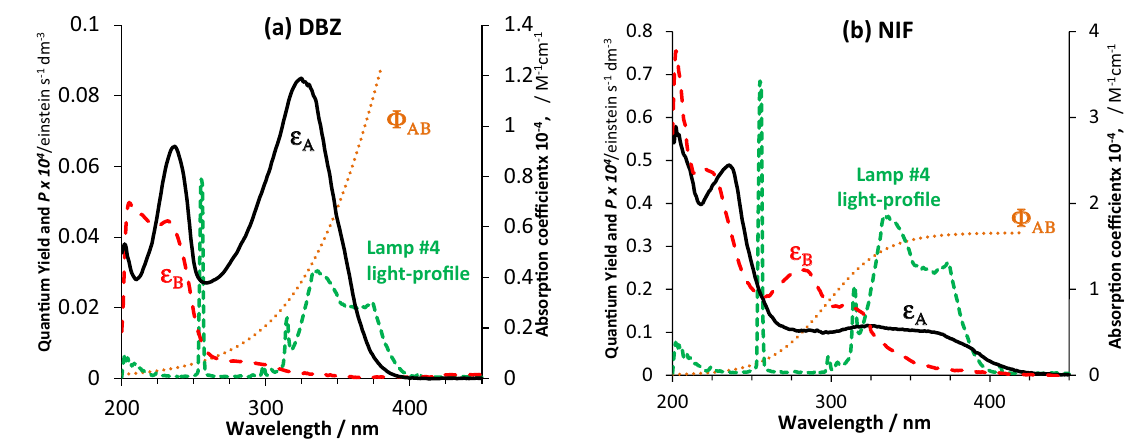
Figure 4. Absorption coefficients of initial drug (ε A ) and its photoproduct (ε B ) for ( a ) DBZ and ( b ) NIF, the mixed (254/365 nm) wavelength light-profile of the irradiation lamp, and the sigmoid patterns of the photochemical reactions’ quantum yields 14,15